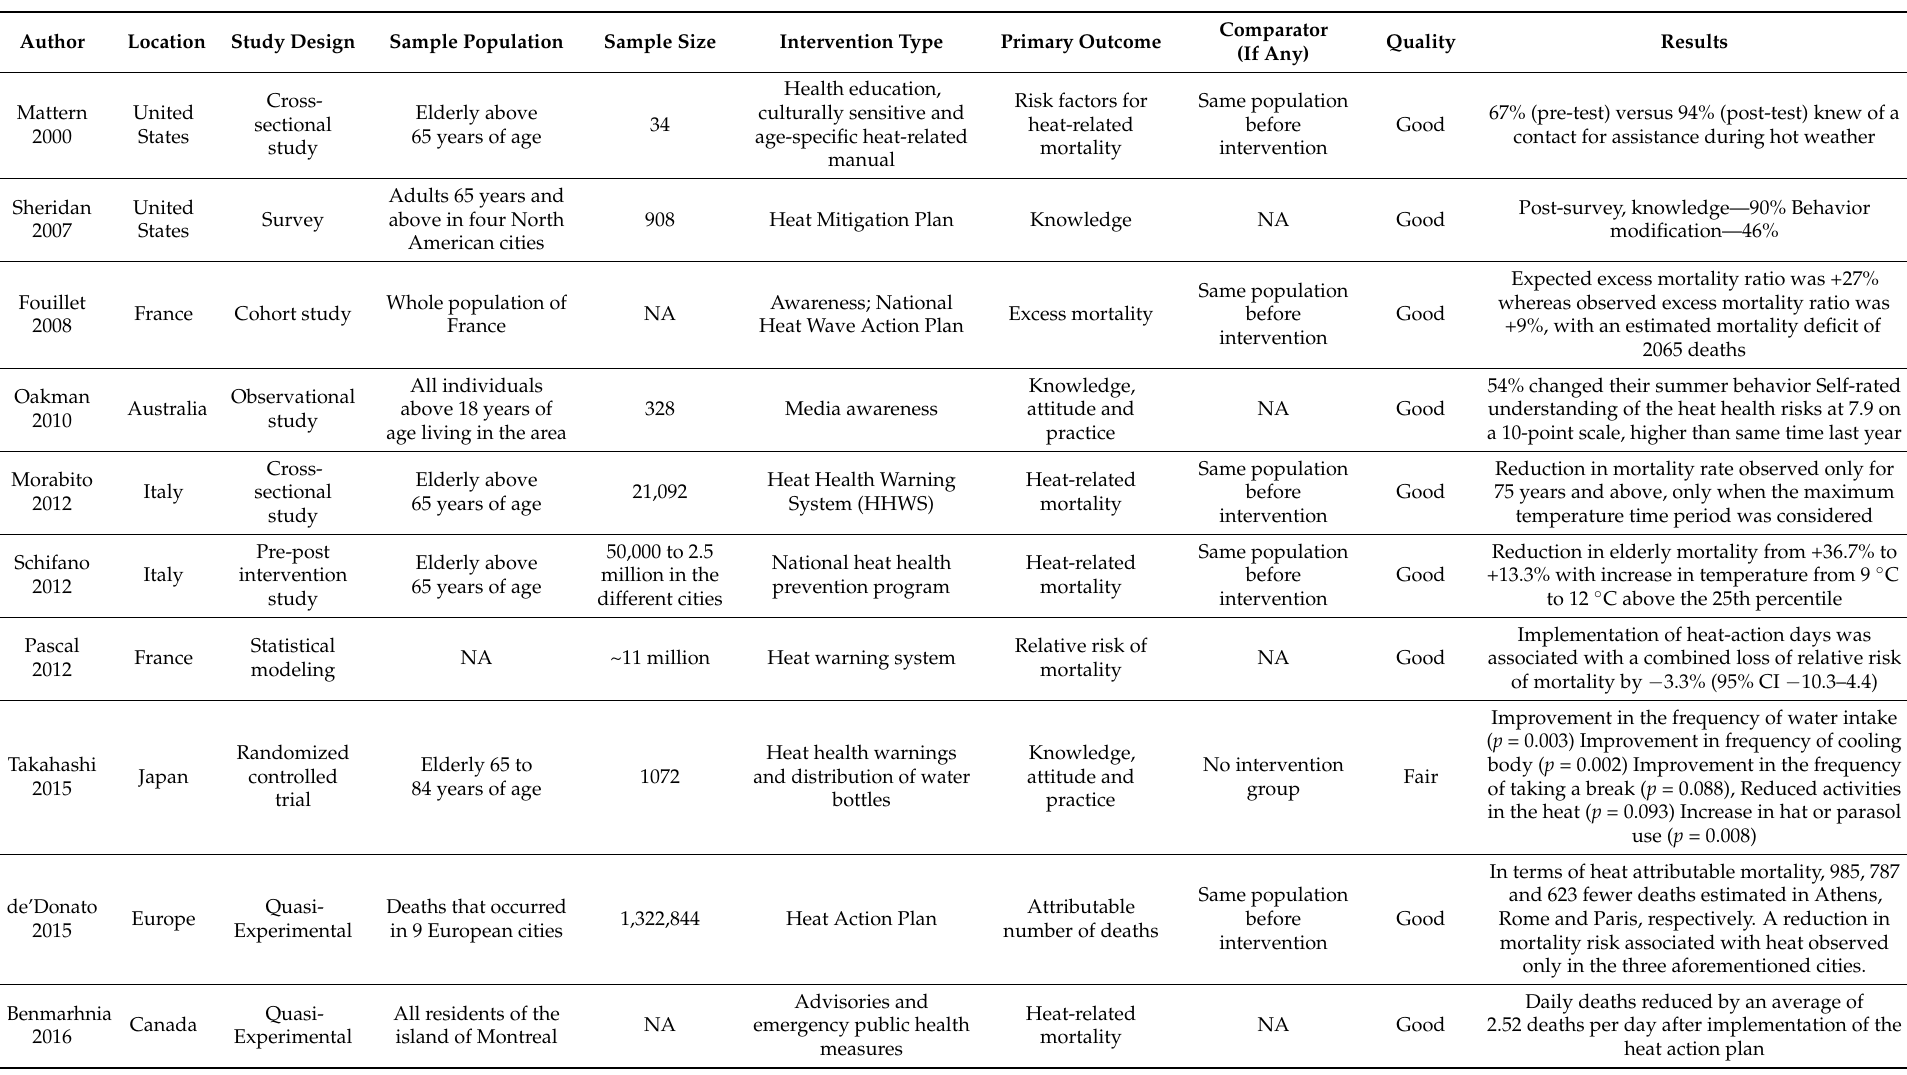
Table 2. Summary of studies on community-based heat-related interventions in urban